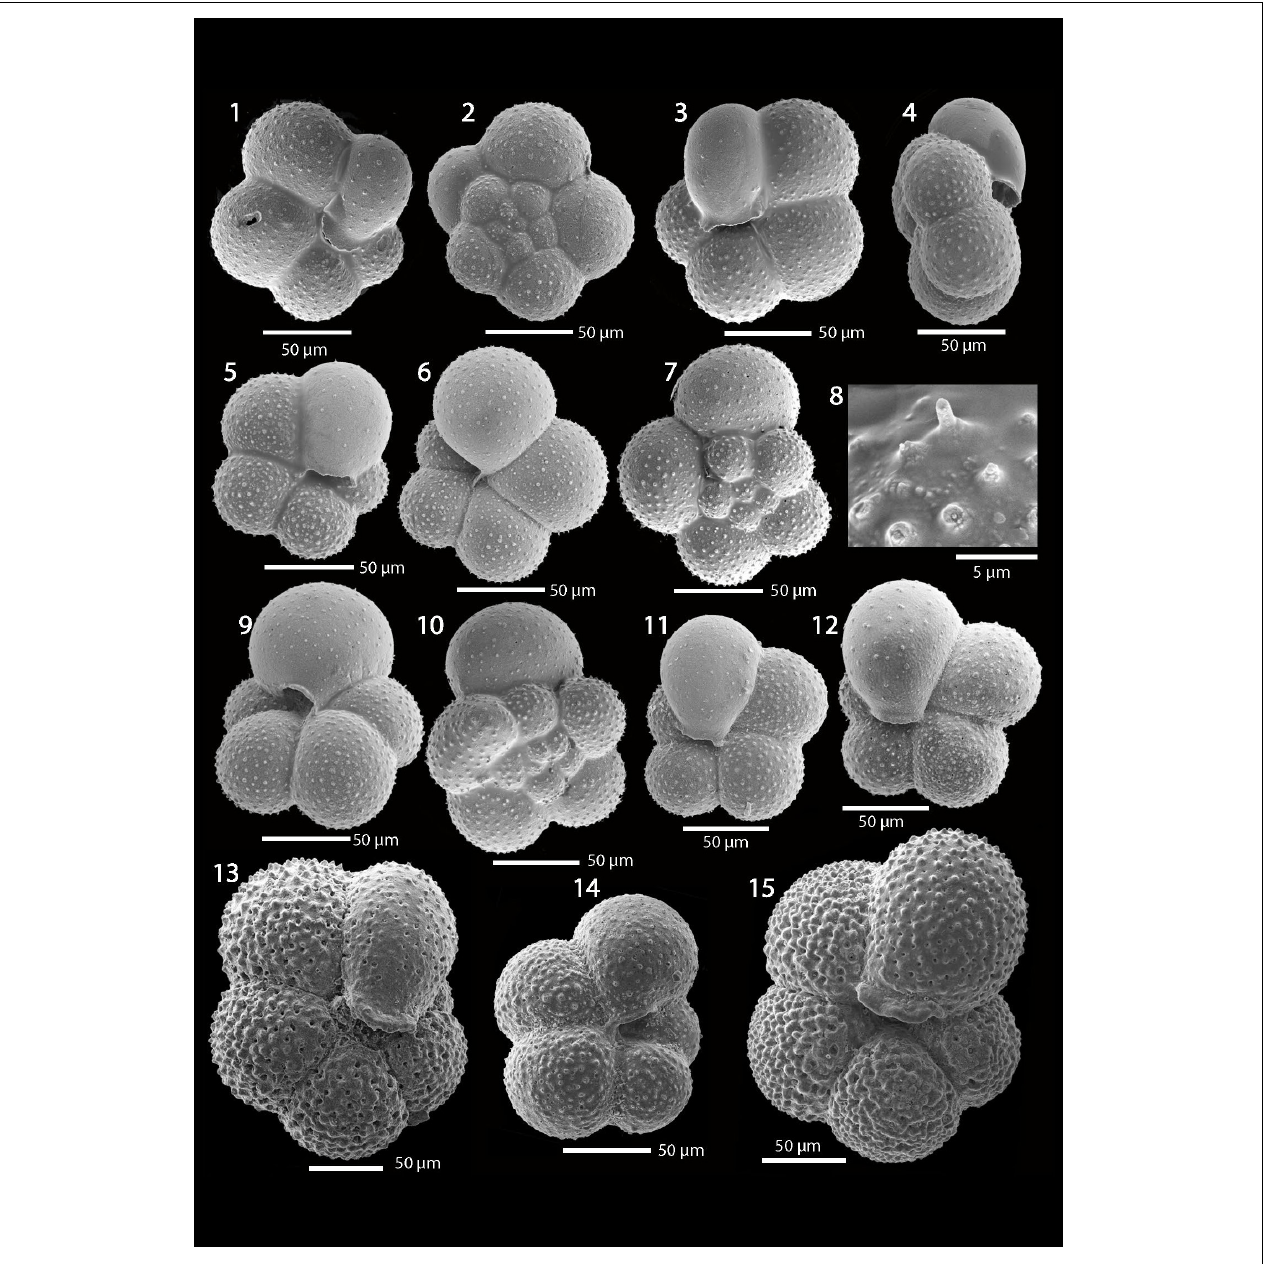
FIGURE 7 | SEM images of Turborotalita from Arctic and Sub-Arctic cores. Images 1–12; Well-preserved examples of T. quinqueloba from Sample LOMROG12 PC 0.7–2 cm and 7–9 cm (0.88 mbsf), probable MIS 5.1. Note these specimens lack an outer gametogenic crust typical of this species (compare to images 13 and 14) but often have the diagnostic ampulate final chamber. Images 1–2, 3–4, 6–8, and 9–10 are different views of the same specimen. The close-up test wall view (8) reveals a broken spine and spine bases diagnostic of the spinose wall texture of T. quinqueloba. Images 13 and 14 are T. quinqueloba from Core M23455, 309.25 cm subsurface, MIS 5, eastern Fram Strait (Van Nieuwenhove et al., 2011). Image 15 is T. quinqueloba from Core M23063, 733 cm subsurface, MIS 11, eastern Norwegian Greenland Sea (Bauch, 1997; Kandiano et al., 2012). Samples from M23063 and M23455 were provided by Antastasia Zhuravleva,